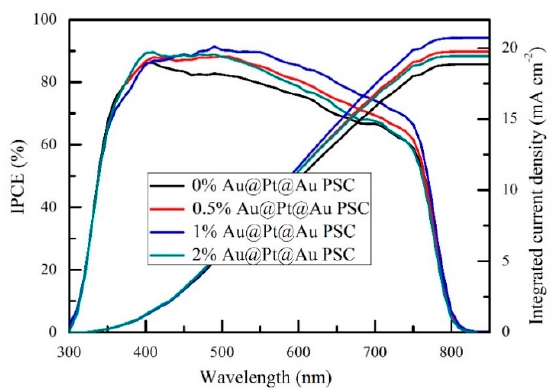
Figure 9. External quantum efficiency spectra and the integrated current density curves of the cells incorporated with different amounts of Au@Pt@Au core-shell NPs.